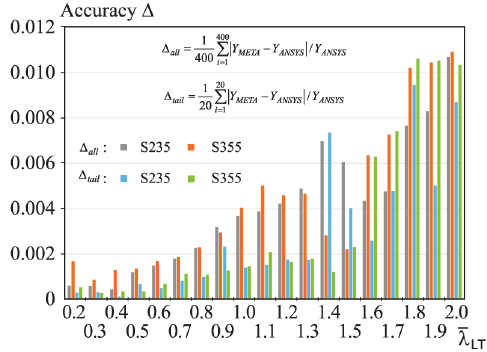
Figure 4. The accuracy of the metamodel (13) 67×49 mm (300×300